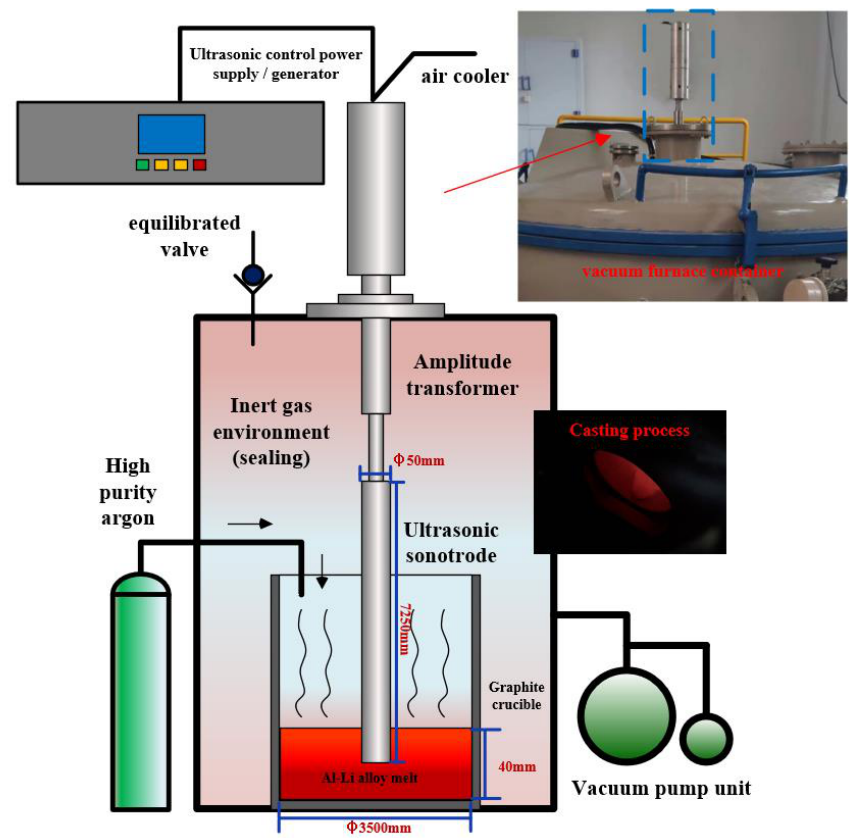
Figure 1. Schematic diagram of ultrasonic system and vacuum system.